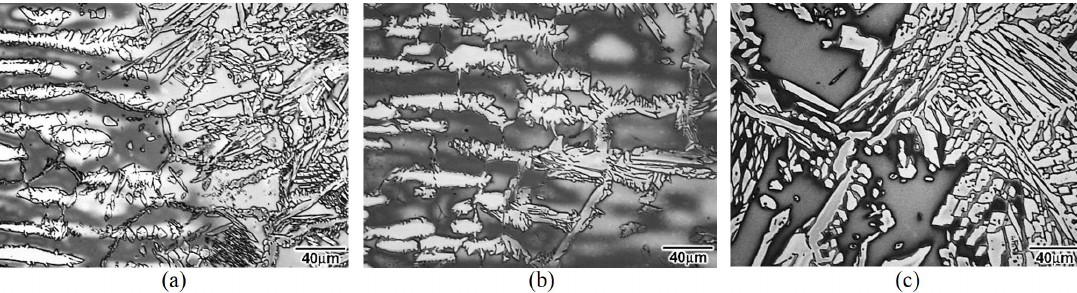
Figure 7. Microstructure of the bounding zone region and the heat-affected zone with high temperature (HAZHT). (a) 0.5 kJ.mm -1 with a ferrite content of 68% and austenite precipitation featuring sawtooth interface; (b) 1.0 kJ.mm -1 with a ferrite content of 65% and austenite precipitation with a sawtooth interface; (c) 3.5 kJ.mm -1 with a ferrite content of 59% (matrix) and austenite precipitation (parallel plates). The shades of grey in the ferrite matrix suggest solute segregation caused by the partial dissolution of the austenite during the welding process. OM, electrolytic etching in KOH solution.